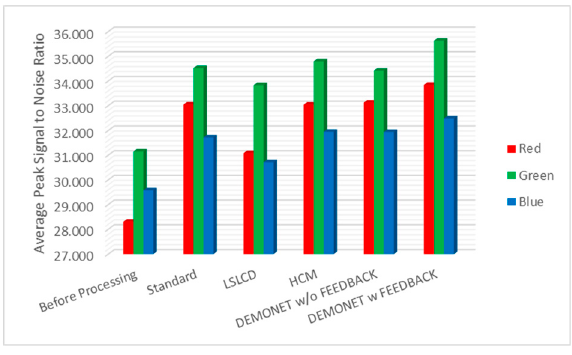
Figure 10. Averaged PSNR values of di ff erent methods for RGB bands.